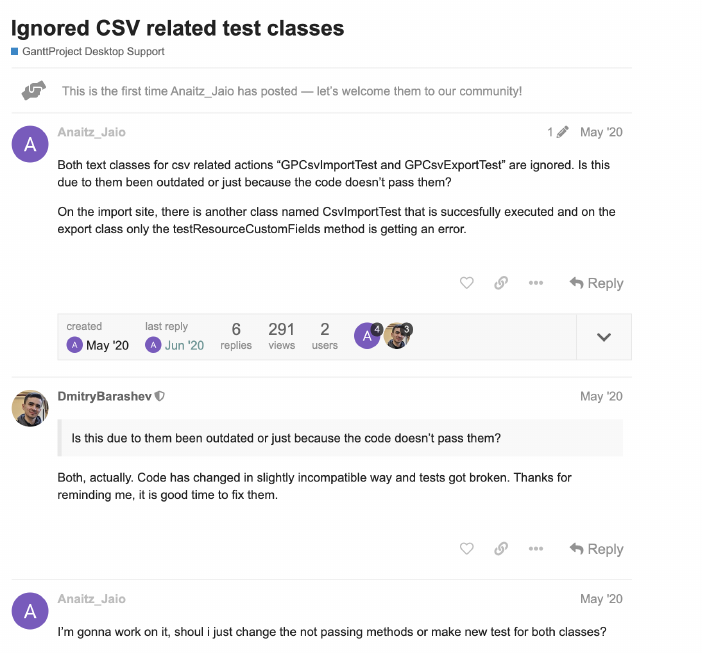
Figure 3. Before solving a problem or beginning an implementation, students should comment on their intentions in the